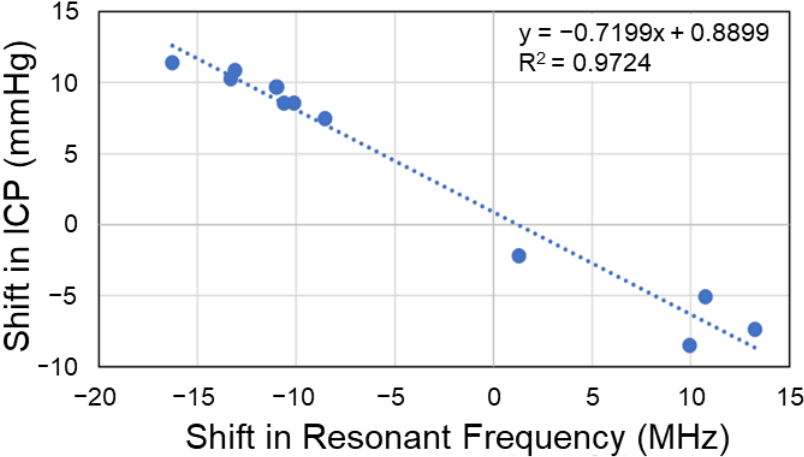
Figure 4. Simple linear regression model relating shifts in EM skin patch sensor’s resonant frequency (predictor) with intracranial pressure (response). RMSE = 1.24 mmHg.